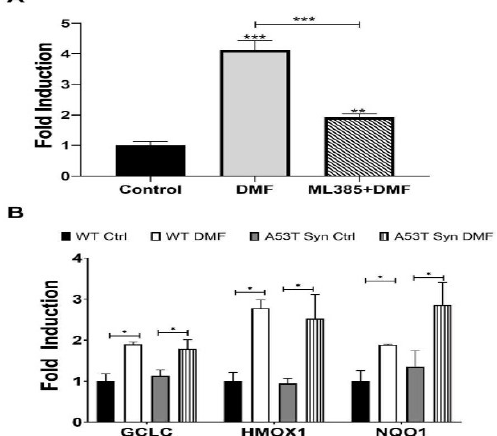
Figure 2. DMF activates NRF2 in vitro and this activation is inhibited by ML385. ( A ) 20 μ M